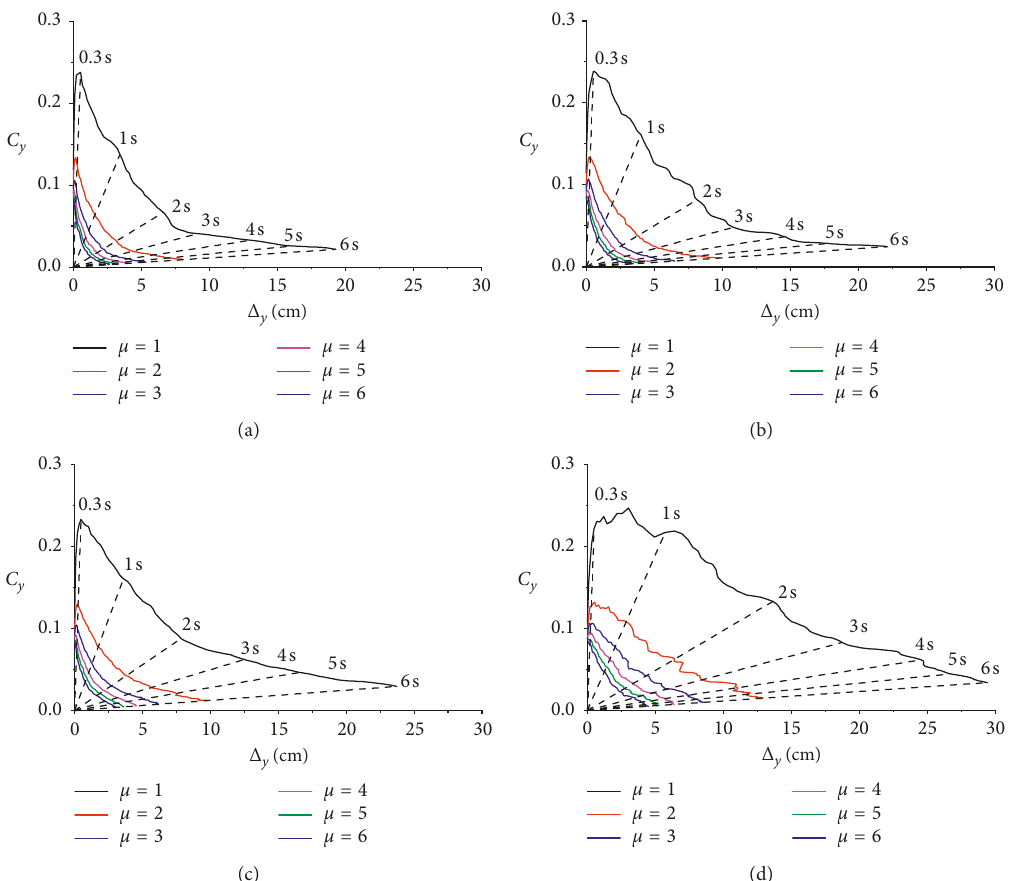
Figure 4: YPS for six-SDOF systems on four different site classes: (a) site B; (b) site C; (c) site D; (d) site